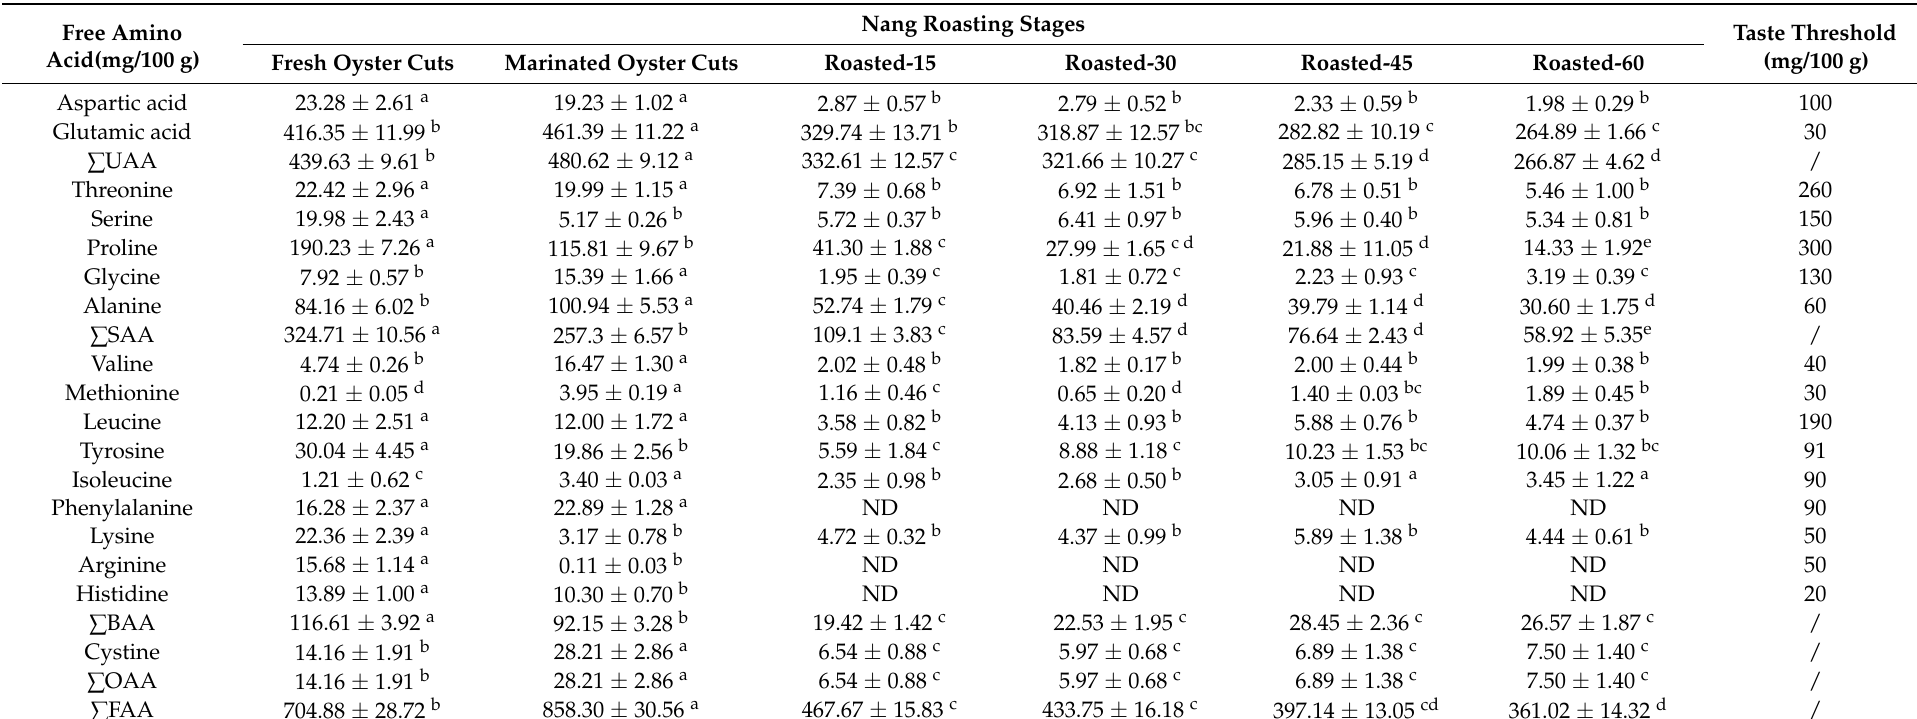
Table 3. Changes of free amino acid content in lamb oyster cuts during Nang roasting (dry matter